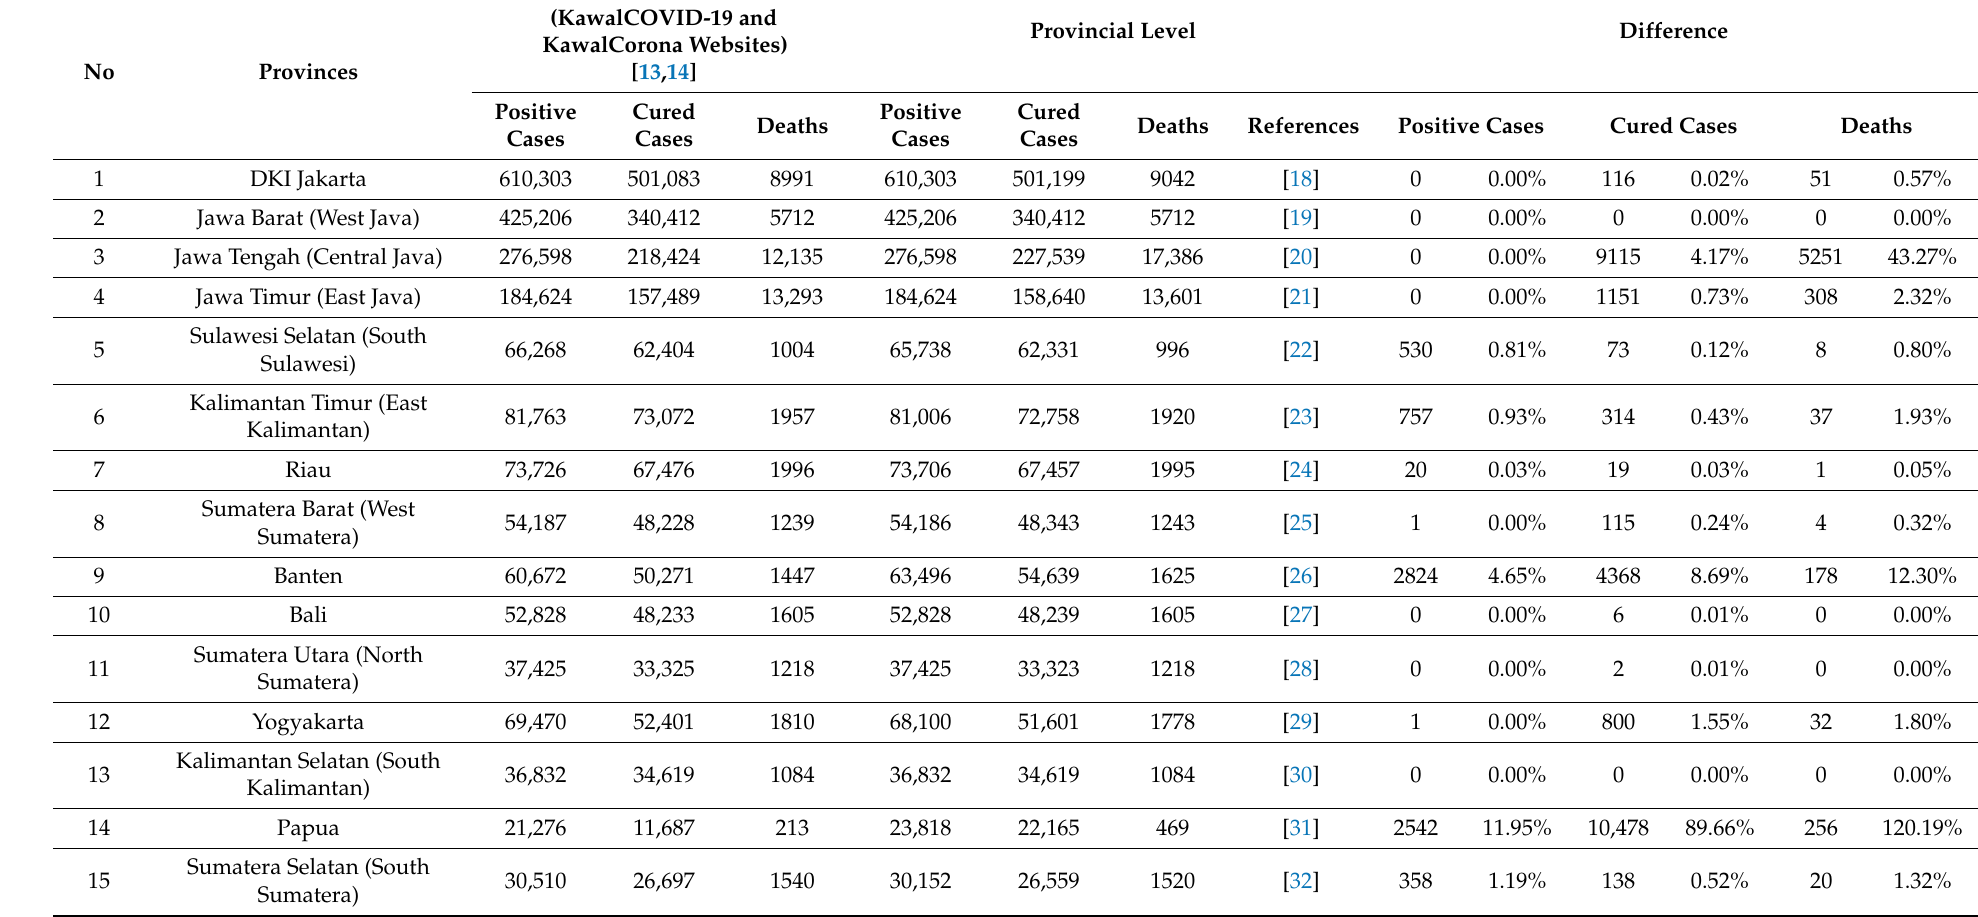
Table 1. Comparison of COVID-19 incidence data at national and provincial